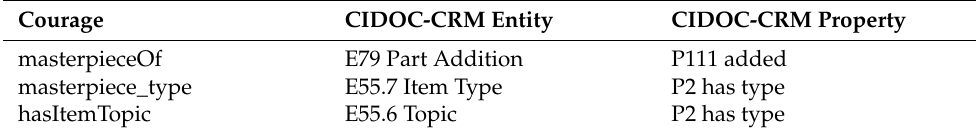
Table 4. COURAGE featured item entity representation in